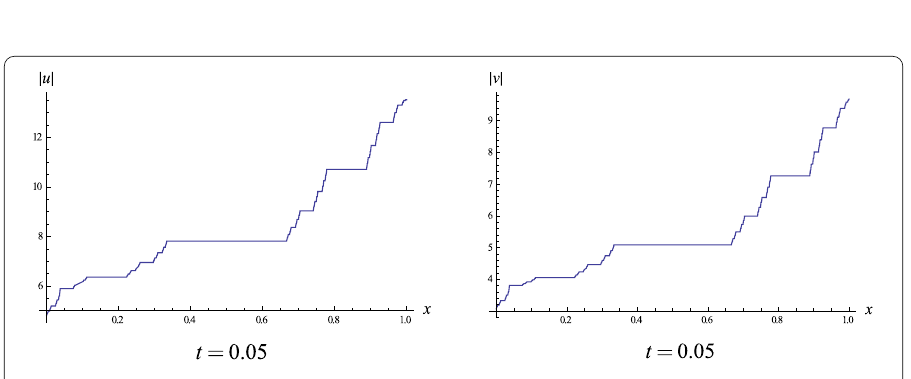
Figure 9 Profiles along the x axis of two-fractal solutions (147) and (148) with α = ln2/ln3.